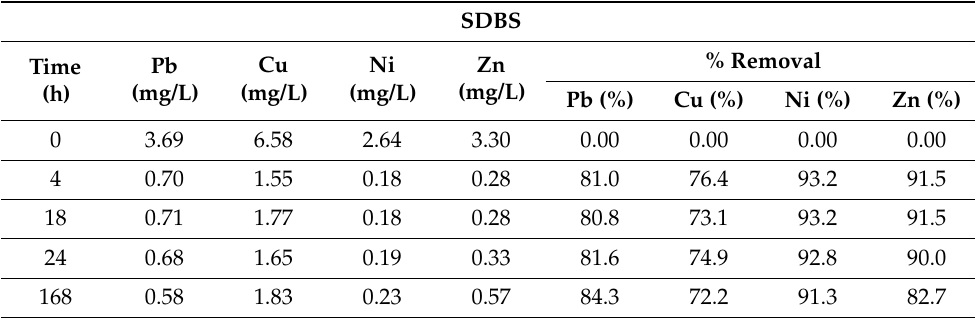
Table 8. Removal of Pb(II), Cu (II), Ni (II) and Zn (II) by a suspension of 0.01% ( w / w ) of MWCNTs with 0.03% ( w / w ) of SDBS, under competitive adsorption conditions between cations.